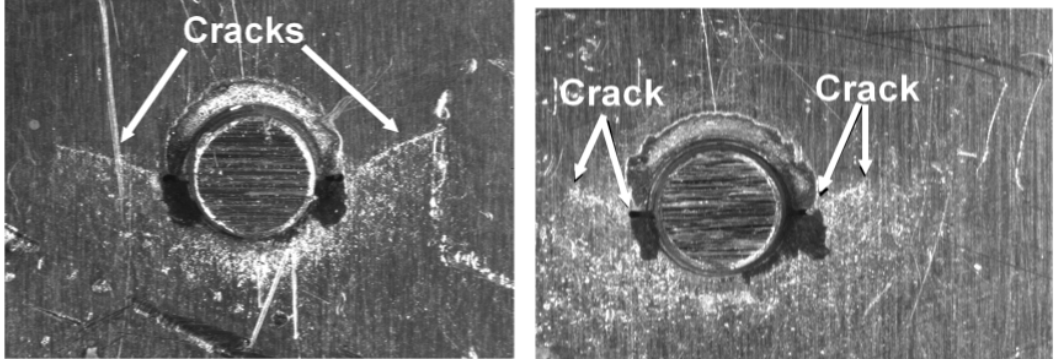
Figure 18. View of the underside (on which the cold spray was not deposited) of the 2024-T3 lap joint skin, where there was no cracking in the cold spray; from [93].